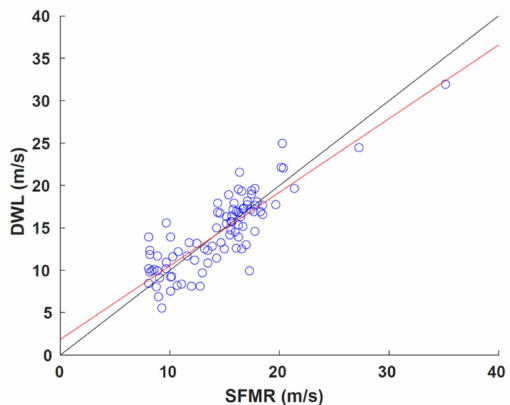
Figure 6. Comparison of collocated ADWL and stepped frequency microwave radiometer (SFMR) wind speed observations (m s − 1 ). Also shown are the line of best fit (red) and the line of perfect correlation (black).